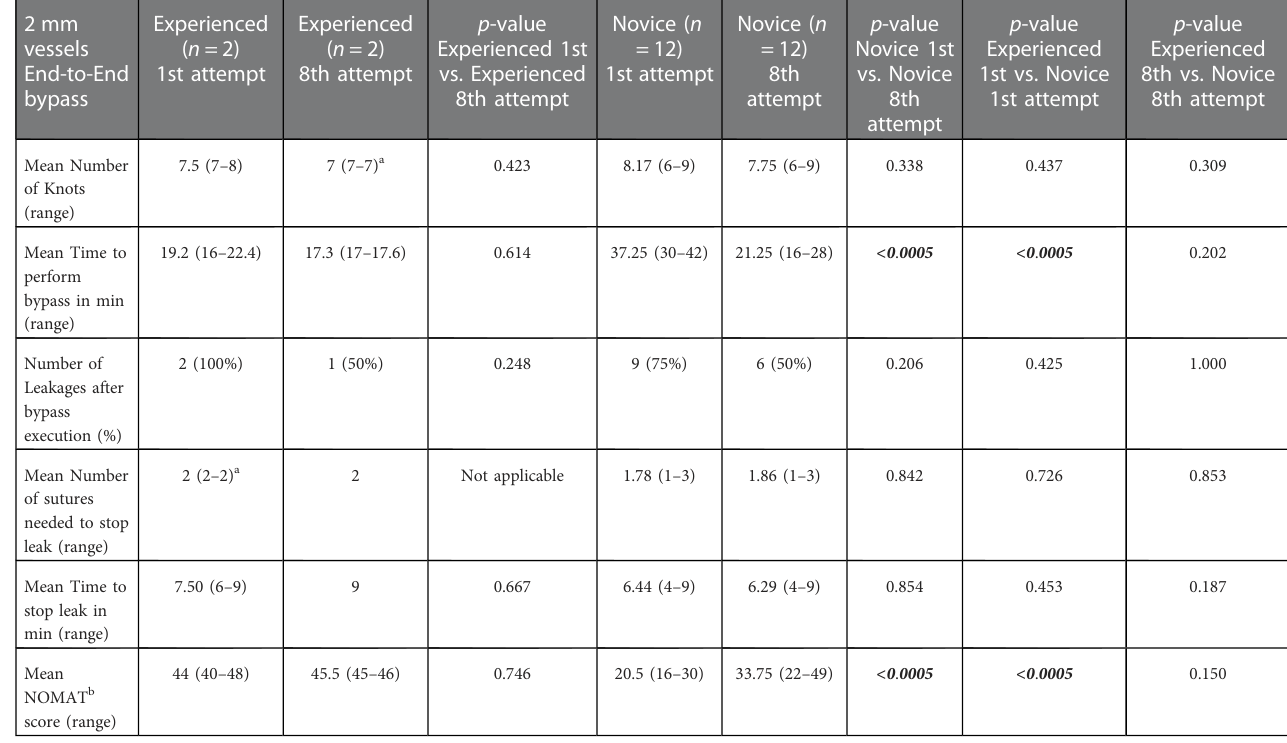
TABLE 1 Results of the NOMAT score and objective task evaluation of the 2 mm vessels end-to-end bypass in each group at 1st and 8th attempts.